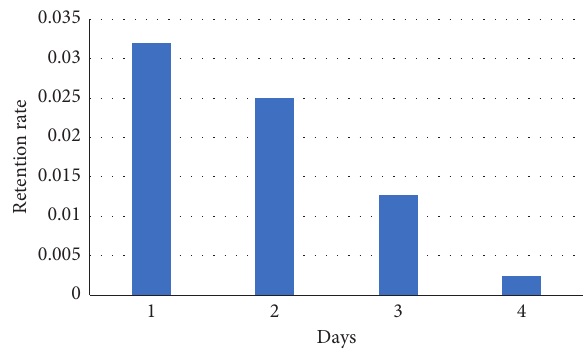
Figure 7: The retention rate across the